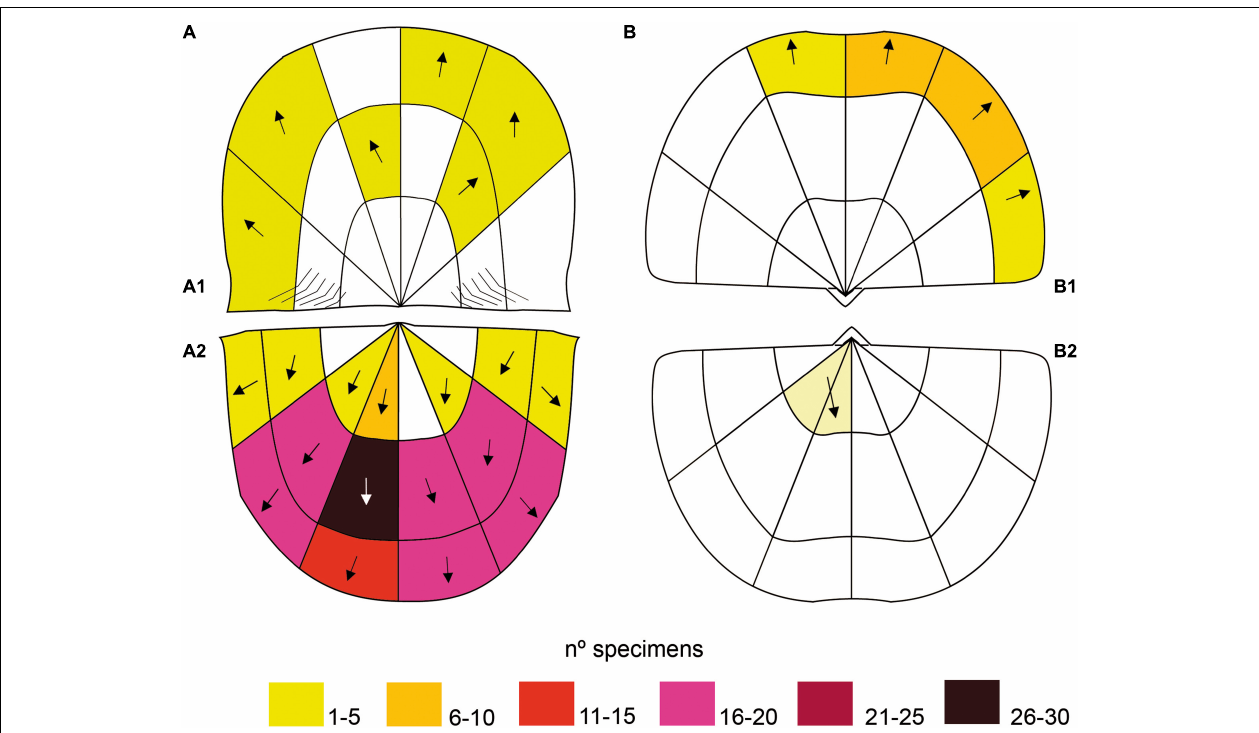
FIGURE 2 | Frequency and spatial distribution of Palaeosabella prisca . (A) On Colaptomena expansa (A1) : Dorsal valve, (A2) : Ventral valve. (B) On Heterorthis retrorsistria . (B1) : Dorsal valve, (B2) : Ventral valve.